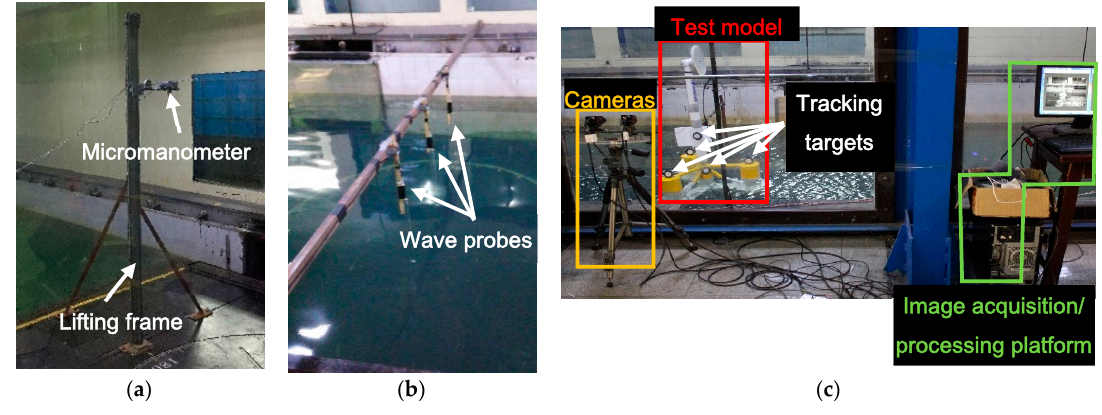
Figure 7. Measuring instruments: ( a ) A micromanometer installed onto a lifting frame; ( b ) Three wave probes; ( c ) The stereo vision measurement system.